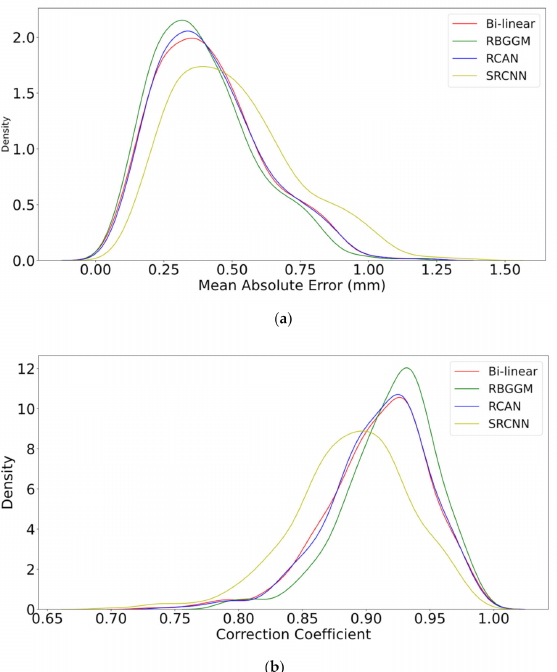
Figure 13. ( a ) PDF distribution of mean absolute error using four methods with a factor of 4 on the test set; and ( b ) PDF distribution of correlation coefficient using four methods with a factor of 4 on the test